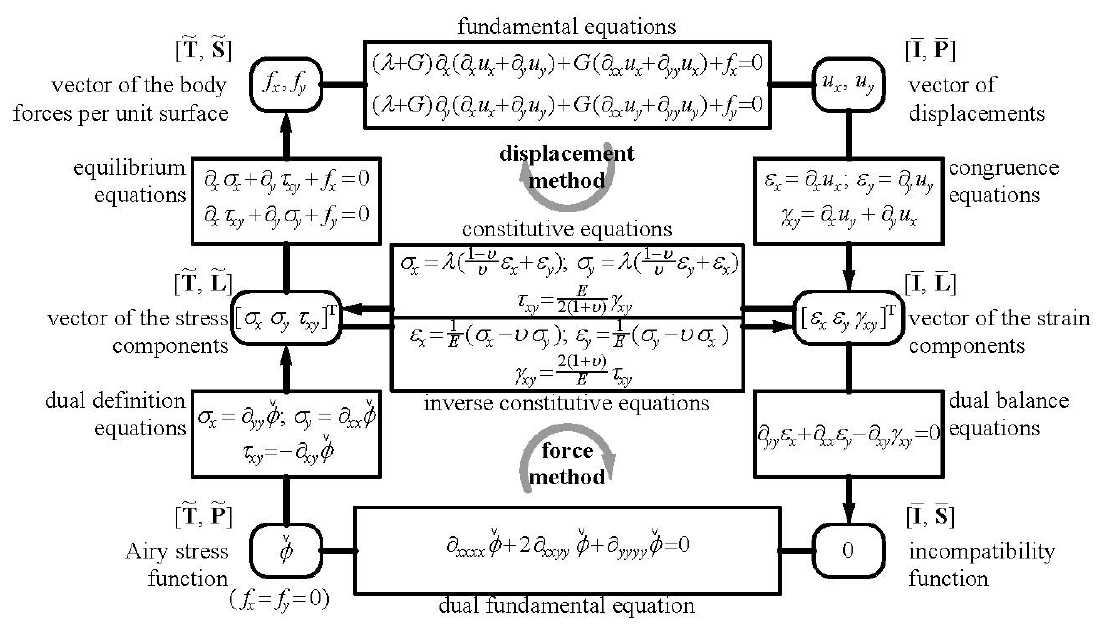
Figure 28: Classification diagram for elastostatics of deformable solids.